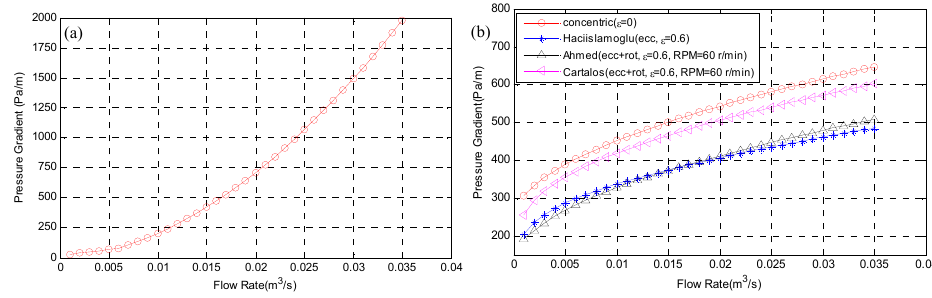
Figure 4. The pressure drop ( a ) in the drill pipe and ( b ) annulus.